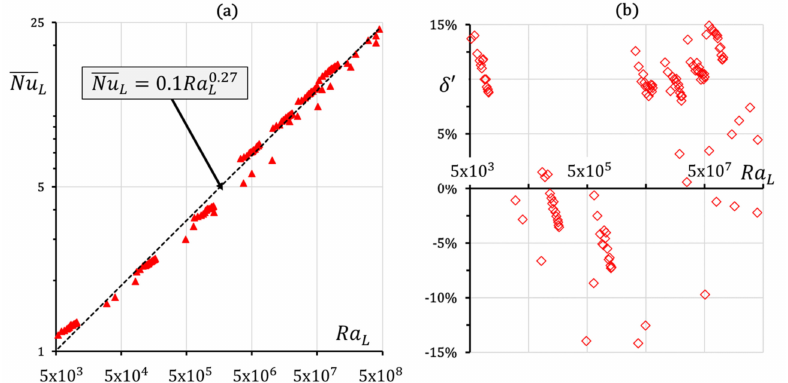
(cid:0) (cid:1) − Nu L s